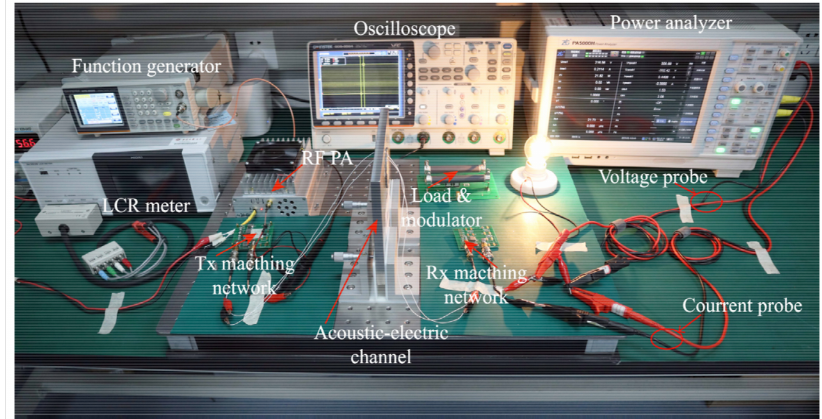
Figure 6. Experimental system (Easily light up a 20 watt incandescent